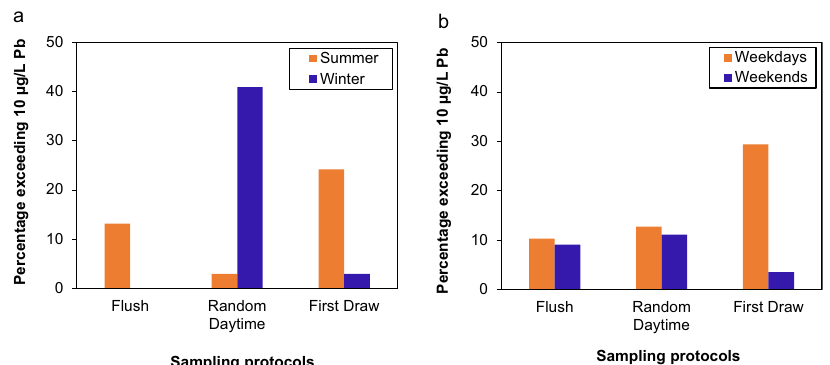
Fig. 6 Effects of water use on Pb exceedance. Variations in Pb exceedance in water samples using three sampling protocols. a Seasonal and b weekday versus